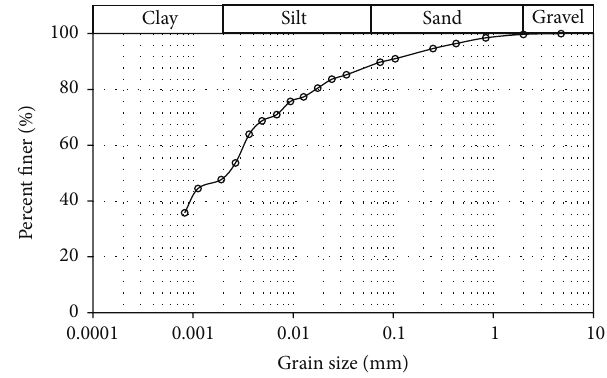
Figure 2: The particle-size distribution of AC.